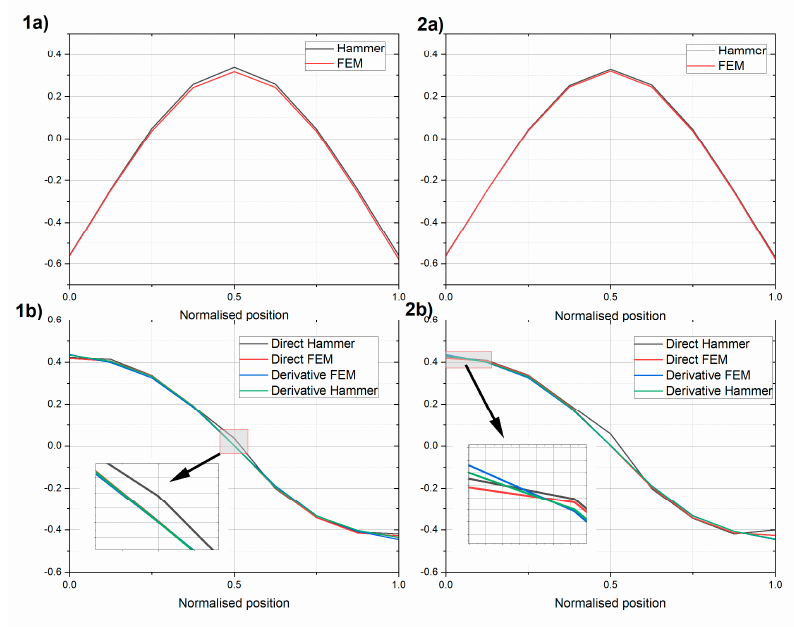
Figure 8. Comparison of the first ( a ) translational and ( b ) rotational mode of (1) beam UHPC1_L and (2) beam UHPC2_L. Results for the intact beams.